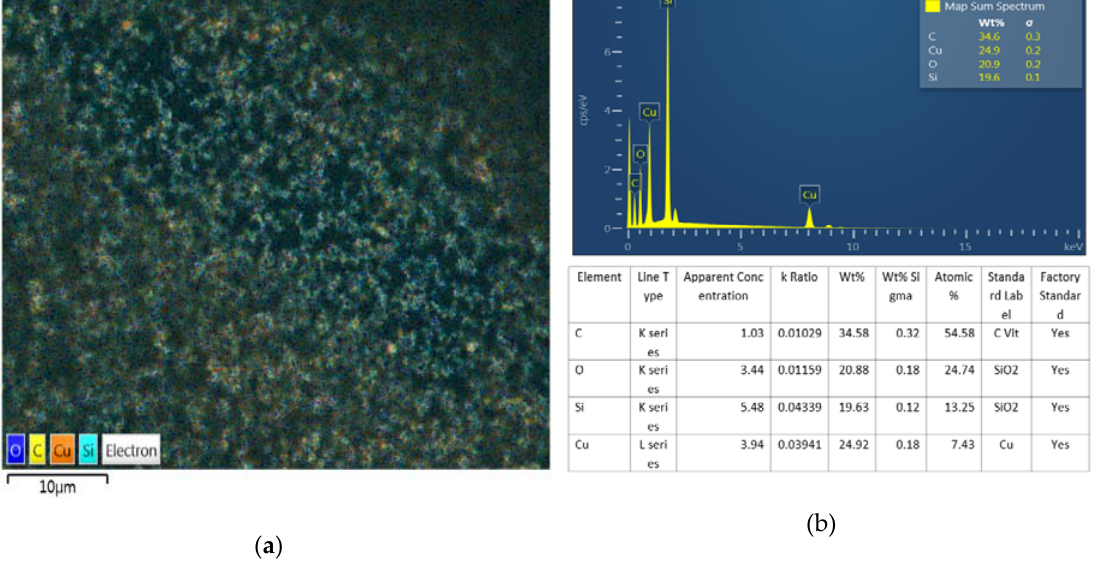
Figure 6. SEM Images of: ( a ) BEI of copper thermal grease and ( b ) EDS of copper thermal grease.